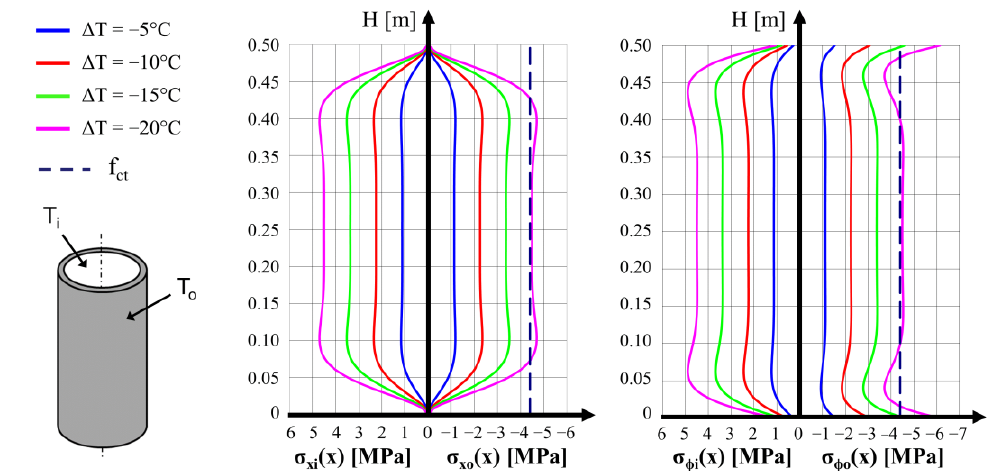
Figure 1. Calculated distributions of thermal stresses along a hollow concrete cylinder 200 mm in diameter. Left and right graphs correspond to longitudinal ( σ x ) and circumferential ( σ ϕ ) stresses, respectively, calculated on the inner and outer surfaces of the hollow cylinder. The concrete tensile strength of axial loading 𝑓 ct is also indicated in the graphs.